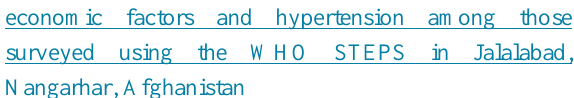
Table 3: Bivariate analysis of bio demographic and socio- economic factors and hypertension among those surveyed using the WHO STEPS in Jalalabad, Nangarhar, Afghanistan